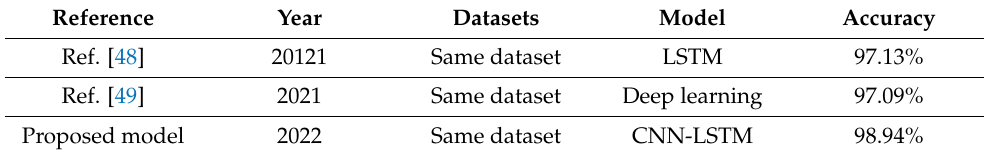
Table 9. Results of the proposed system against existing security systems using the same datasets.